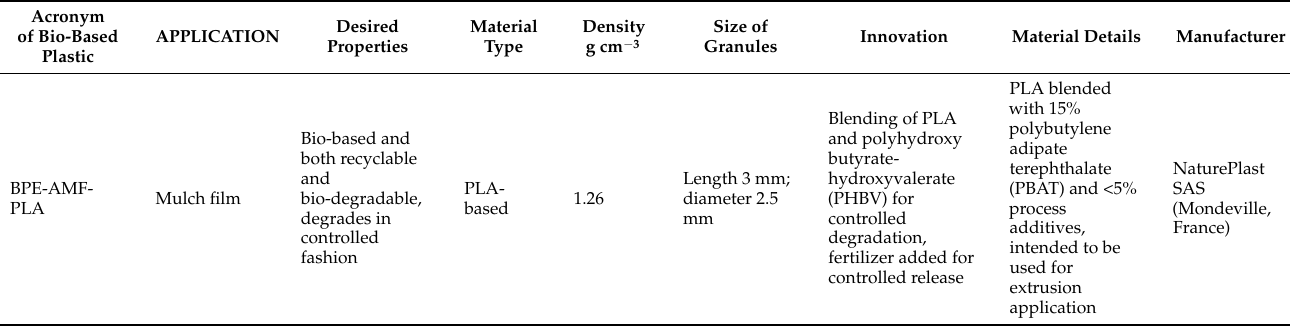
Table 1. Data on the bio-based plastics tested (provided by the